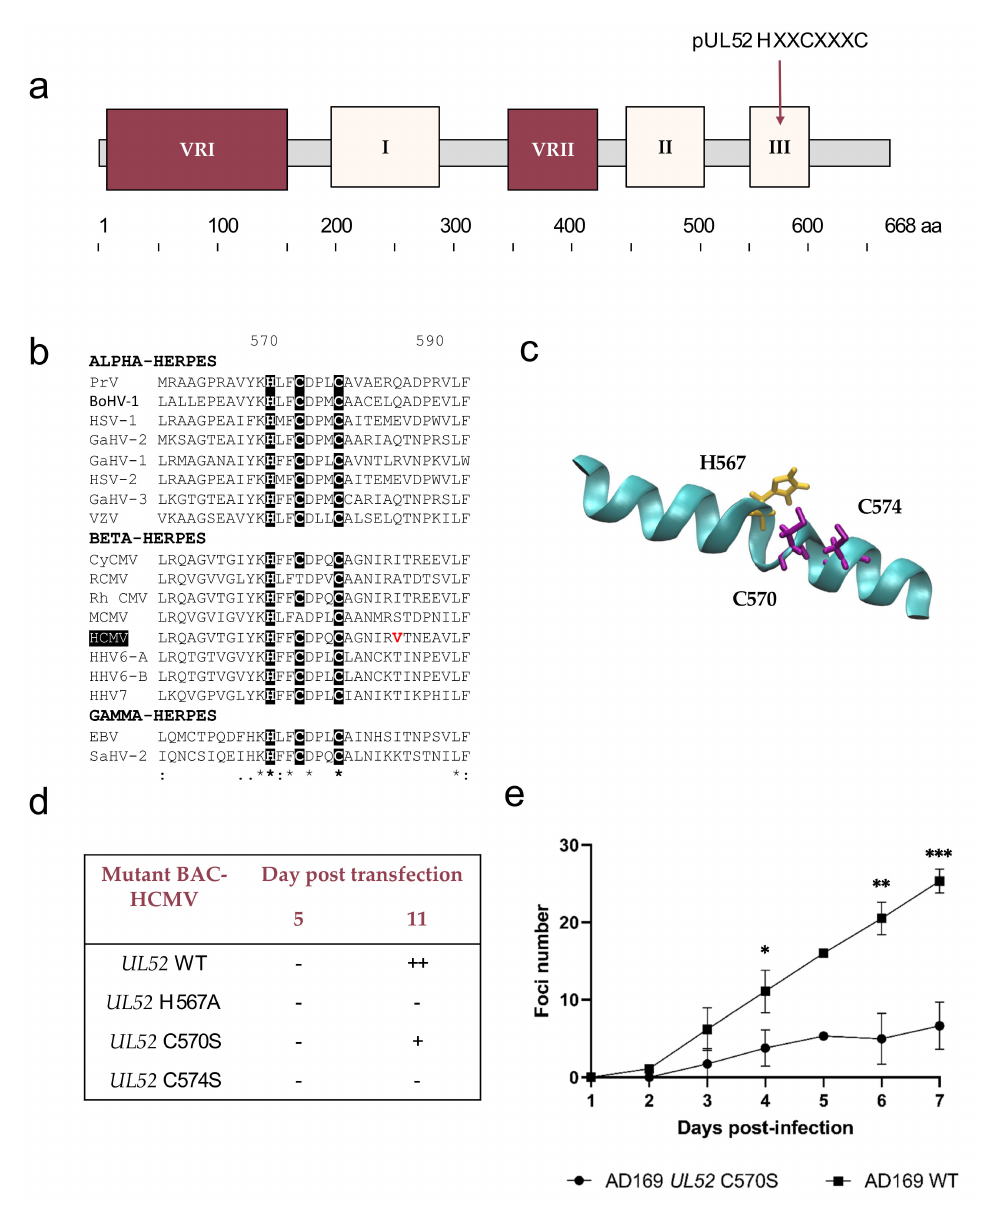
Figure 5. HXXCXXXC motif in conserved Region III. ( a ) Structure of HCMV pUL52 with an HXXCXXXC motif. ( b ) Sequence alignment of the conserved region III from 18 herpesviruses and residues involved in an HXXCXXC motif. Sequence numbering is consistent with that of HCMV reference strain AD169 residues. Key residues involved in the formation of the HXXCXXC motif are shown as white letters on black background. The residue in red matches the position of the mutation V580I found in one of the 61 naive strains. ( c ) Region 3 was extracted from the pUL52 theoretical structure. Cysteines and histidine are represented in purple and yellow, respectively. ( d ) Impact of HCMV-BAC-UL52 mutants on growth in cell culture at day 11 (fibroblasts MRC-5). ( e ) Growth curves of the recombinant virus strain HCMV-BAC- UL52 - C570S in comparison to the parental strain HCMV-BAC AD169 WT. Fluorescent foci were counted daily from day 1 to day 7. Curves are the average of three independent experiments. * p < 0.05; ** p < 0.01; *** p < 0.001 (Mann–Whitney test). VRI and VRII: variable regions I and II. aa: amino